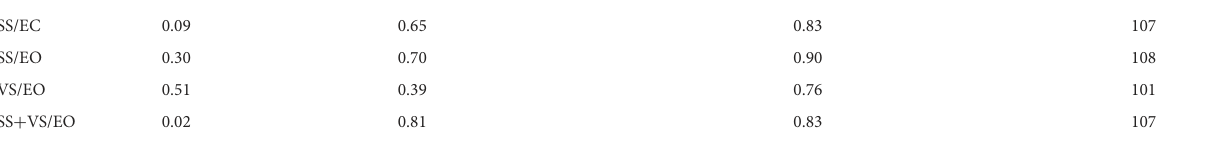
TABLE 4 Variance (r 2 ) of RMS value of CoM stimulus-evoked sway explained by sensory weight factor alone, stiffness-related sway amplification factor alone, and product of the sensory weight with the stiffness-related sway amplification factor.